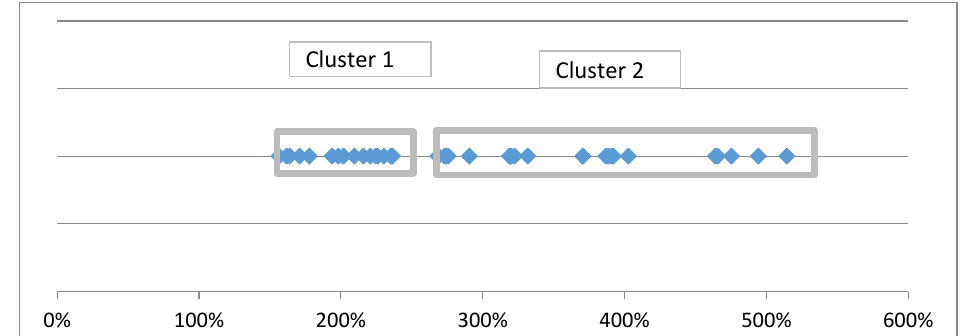
Figure A2. Percentage increase in estimated prices per kilometer in 2015–2016 compared to prices actually paid.